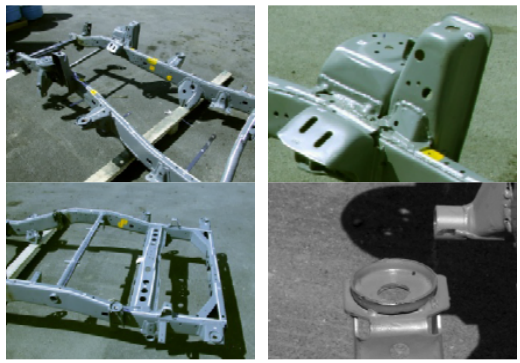
Figure 1. different components of the case study